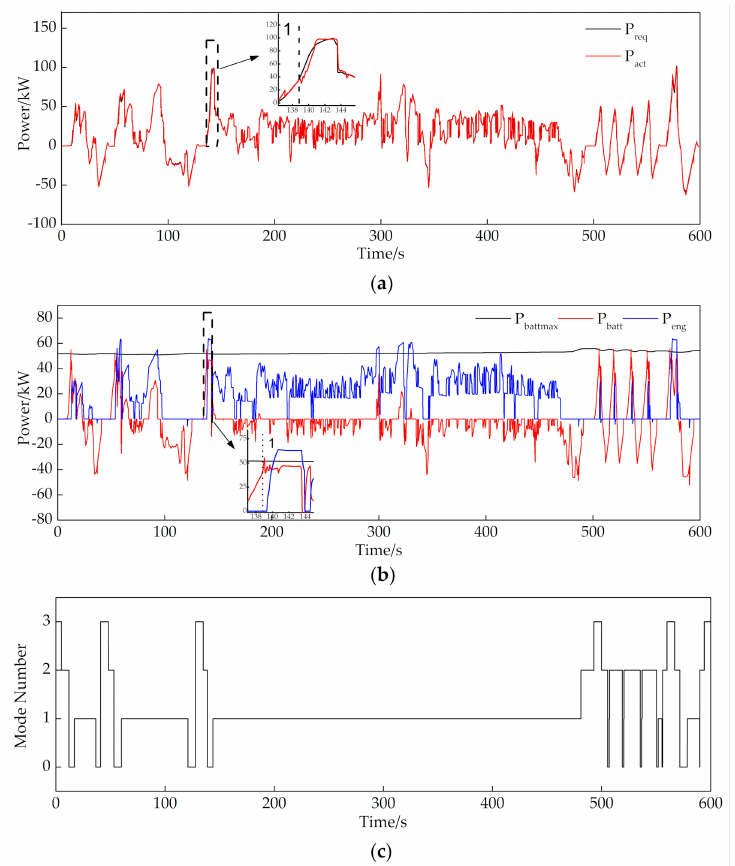
Figure 13. Results of LTB strategy under US06 cycle: ( a ) driving power; ( b ) battery power and engine power; ( c ) target operating